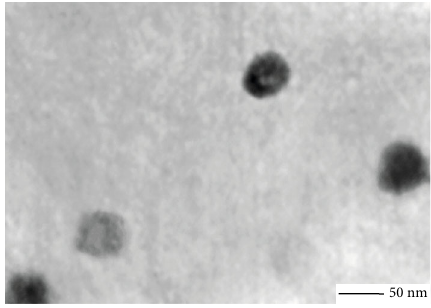
Figure 2: Transmission electron microscope image of melatonin- loaded nanoparticles (MTNPs).